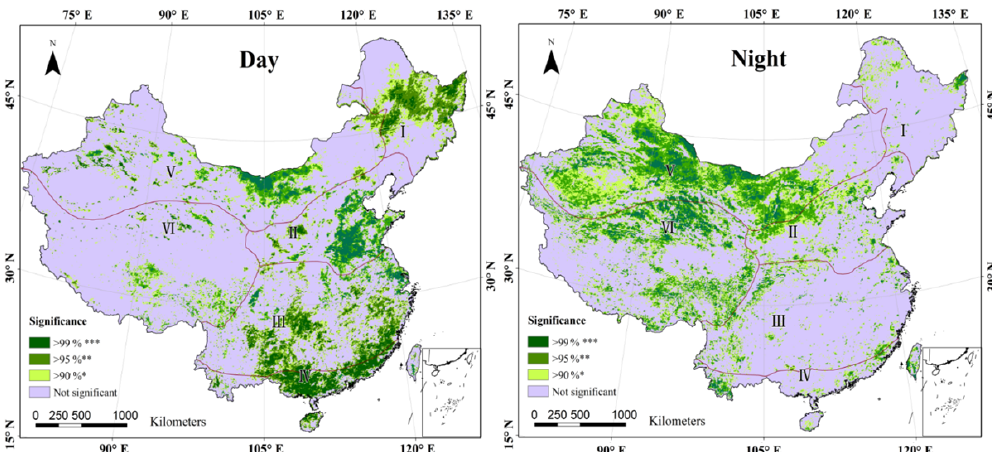
Figure A3. Distribution of diurnal LST change trend significance during